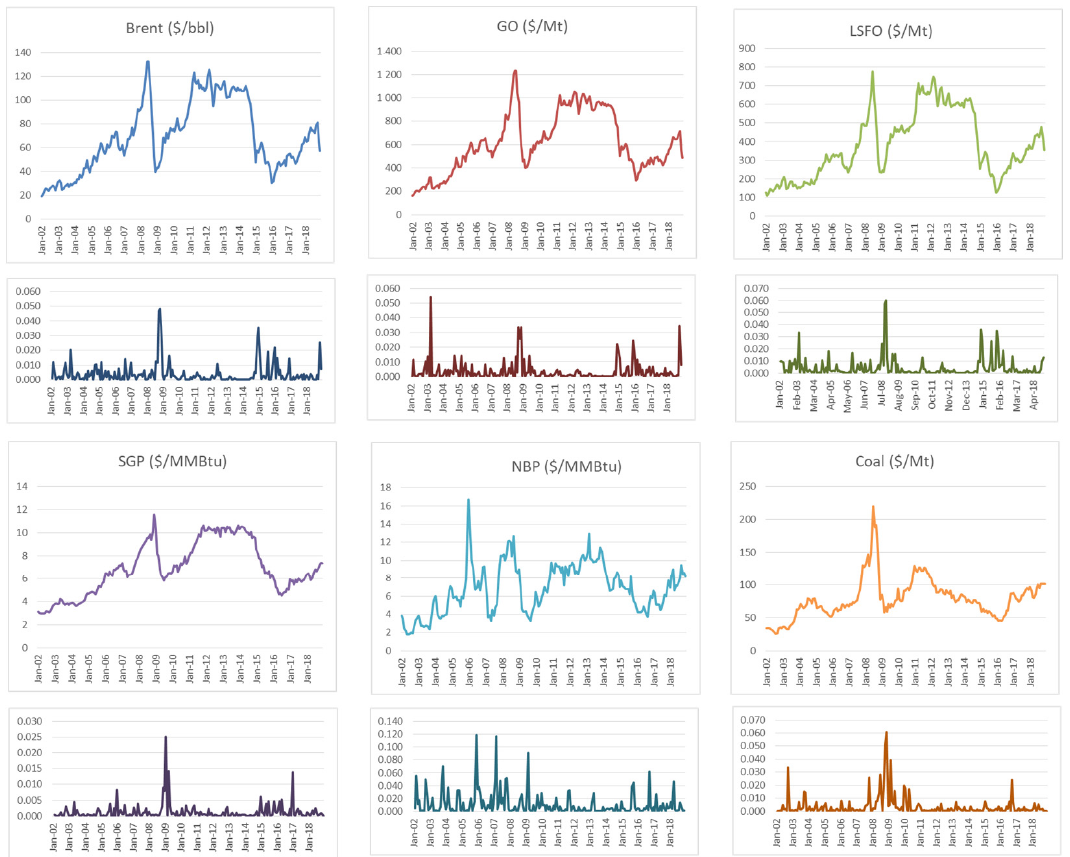
Figure 2. Evolution of Brent, gasoil, fuel oil, Spanish gas import prices (SGP), national balancing point (NBP), and coal prices (above) and absolute returns (below) for each of the variables considered. As can be seen, Brent crude oil and oil products data sets share large swings in common, and at the same time show similar upward trends in spite of the e ff ects of shocks during 2008 and pulling down the trend line with no clear indication of mean reversion. Common peaks anticipating